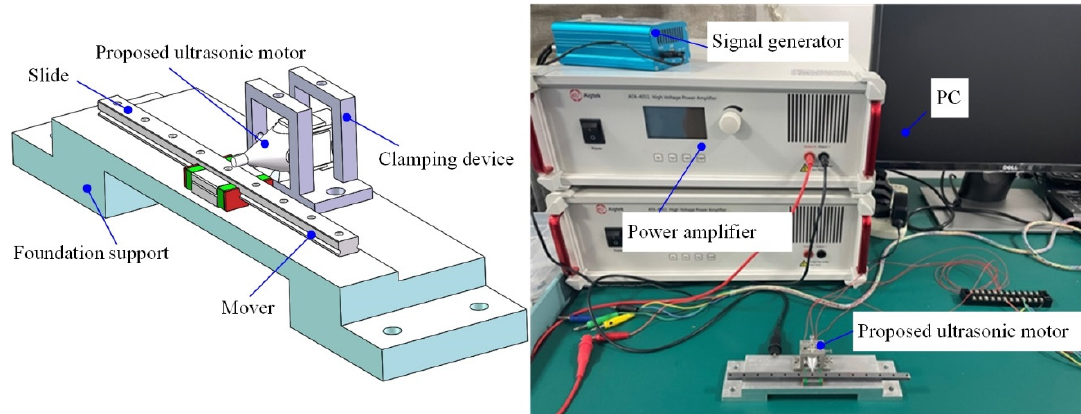
Figure 7. The clamping device and the experimental setup.